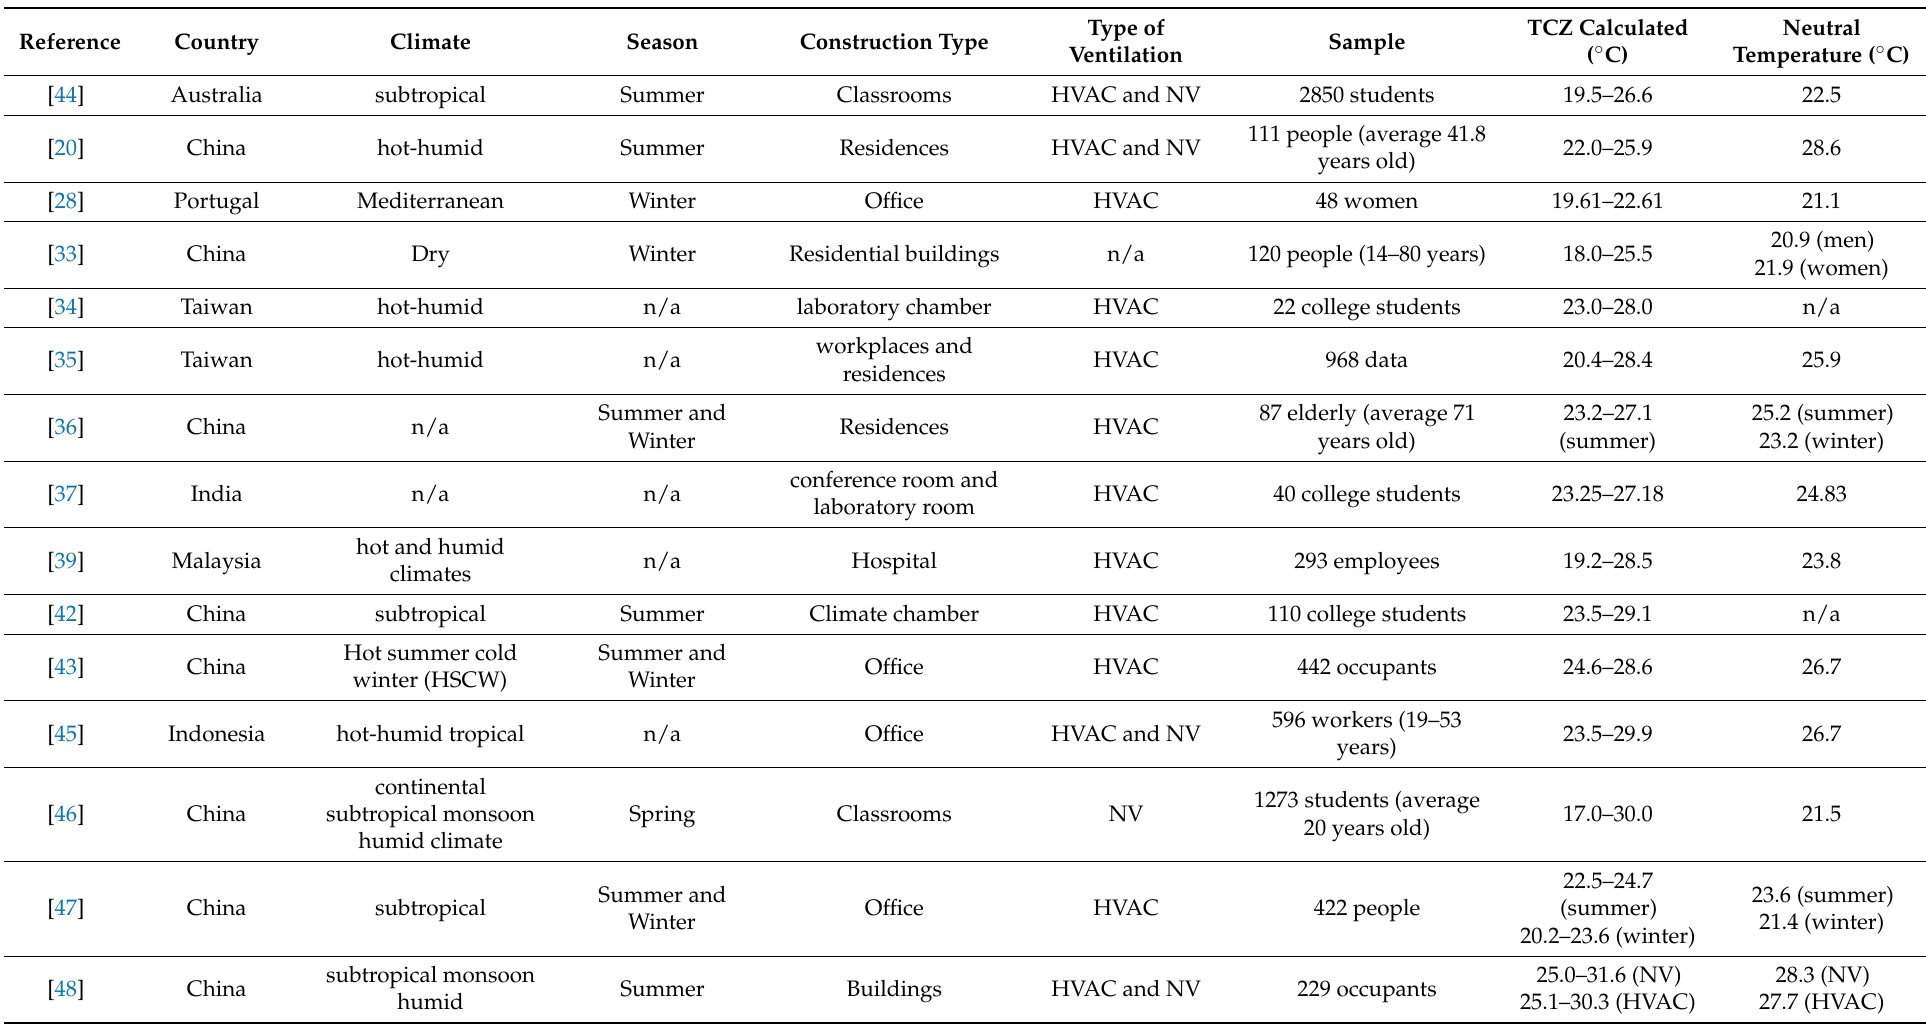
Table 3. Alternatives Thermal Comfort